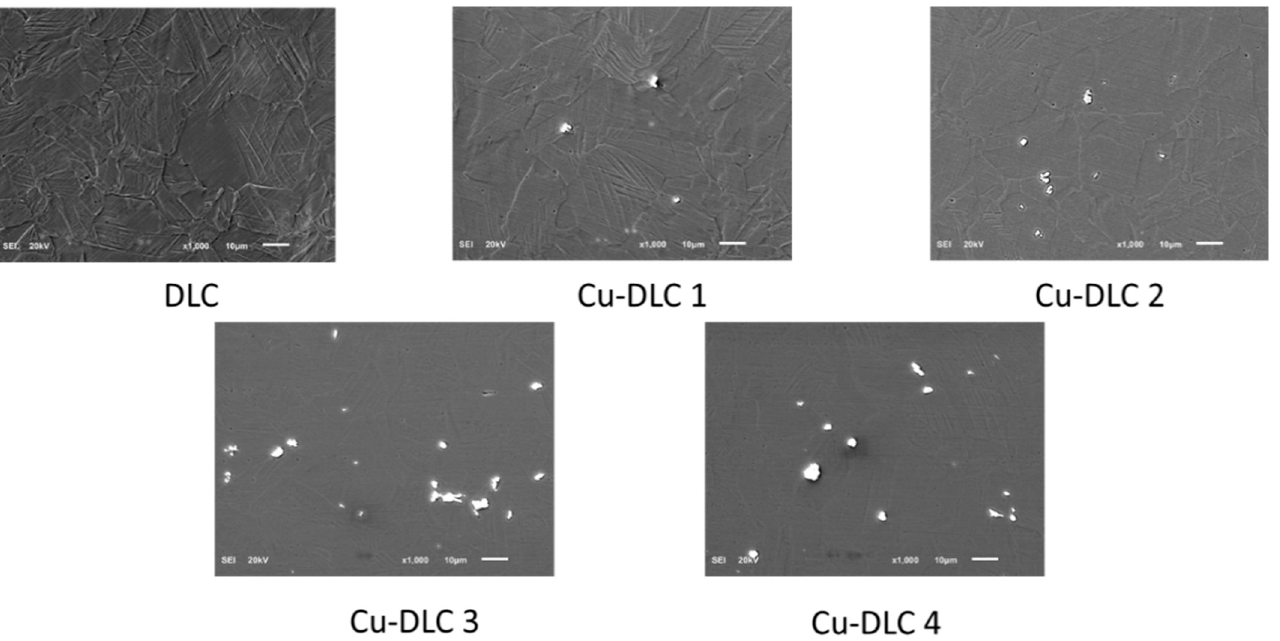
Figure 1. Exemplary SEM pictures of Cu-DLC (diamond-like carbon) coatings deposited on AISI 316 LVM (magnification × 1000, secondary electron image (SEI) mode).